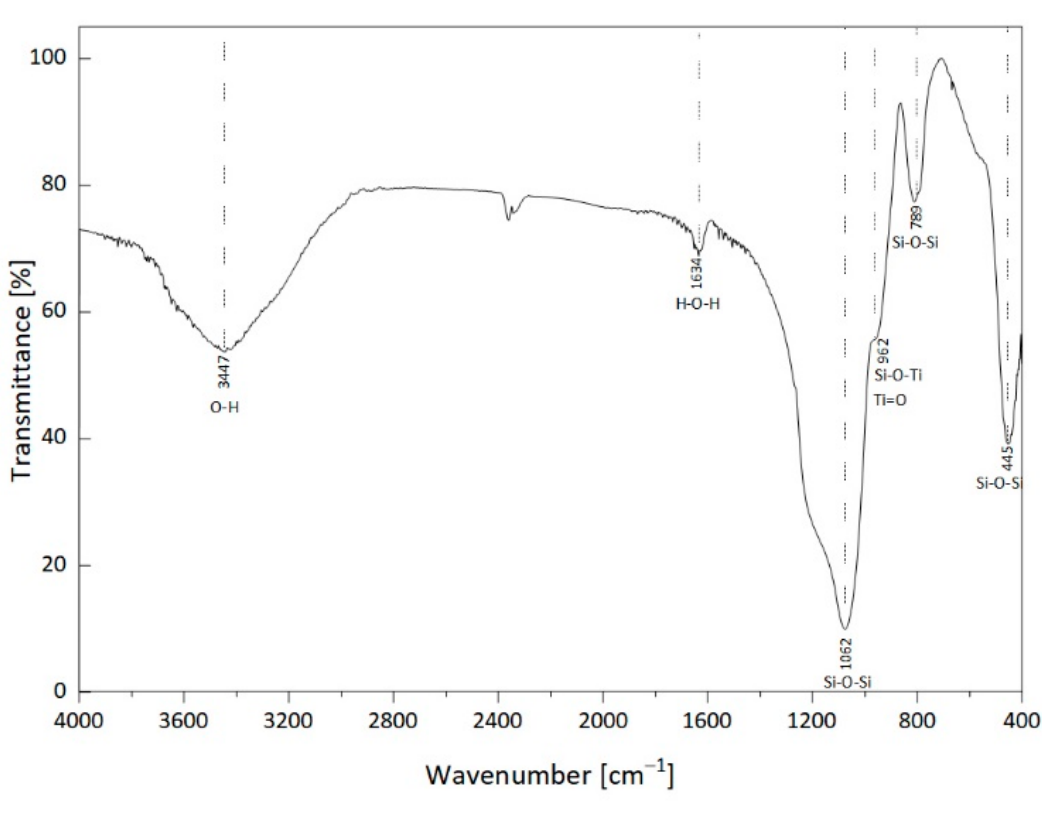
Figure 8. FTIR spectrum of the Ti-SBA-16 material.